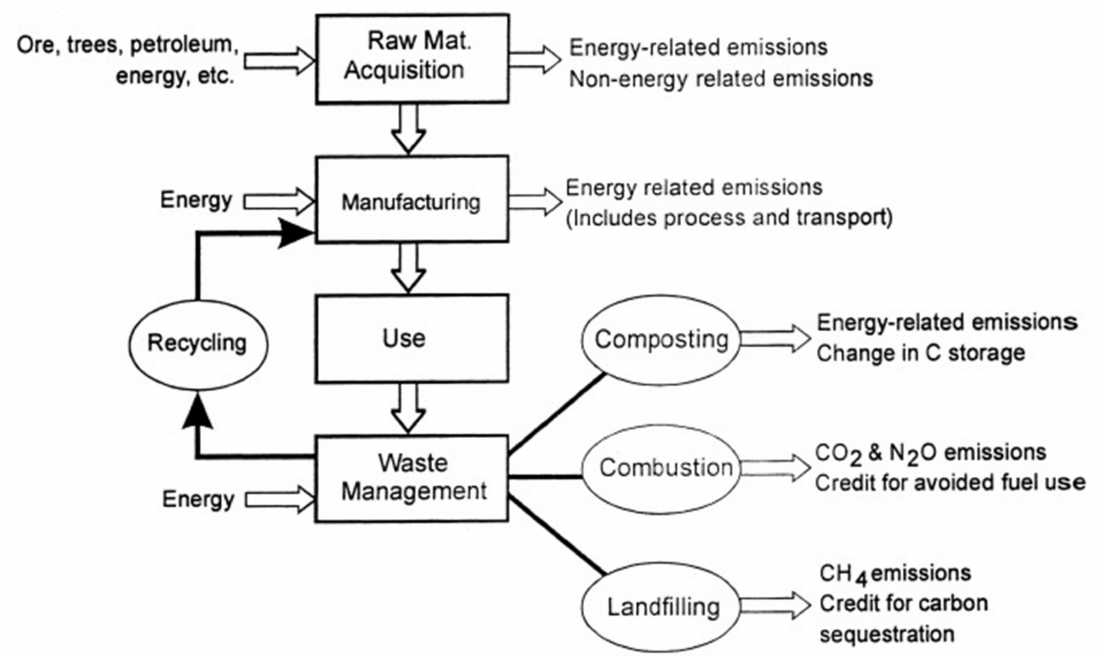
Figure 4. Municipal solid-waste life cycle. Reprinted from [36], © 2020 with permission from